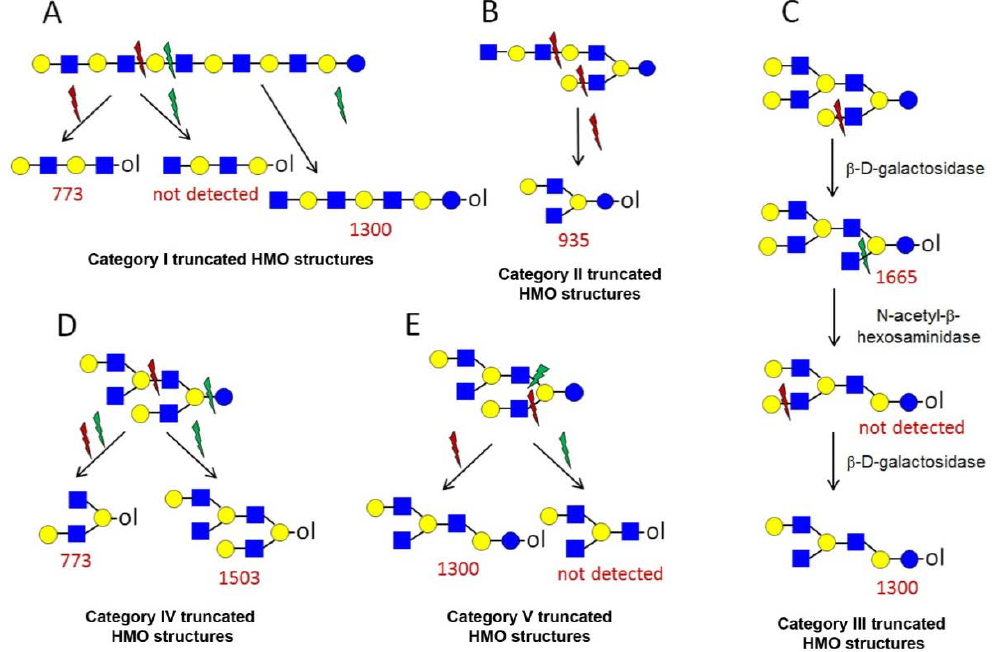
Figure 6. The formation of truncated oligosaccharide structures in the human milk oligosaccharide (HMO) fraction. and depict various possible hydrolysis events, each of which, alone ( A – D right, E ) or combined ( D left), yield different oligosaccharide structure types shown in the figure. denotes N -acetylglucosamine, galactose and